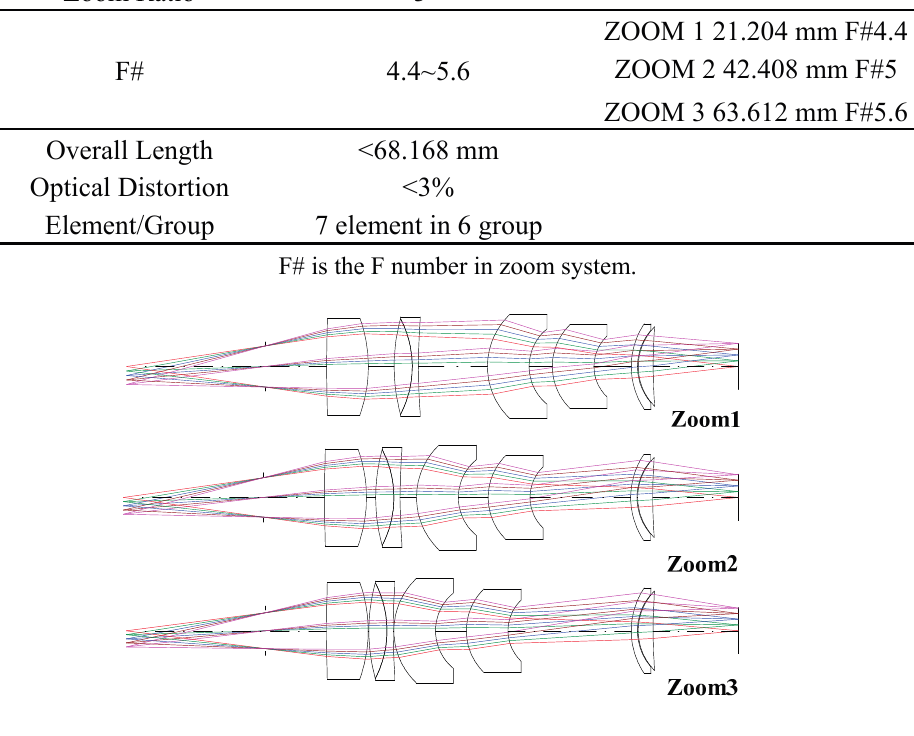
Figure 4. The structure of back zoom lens with 3× zoom